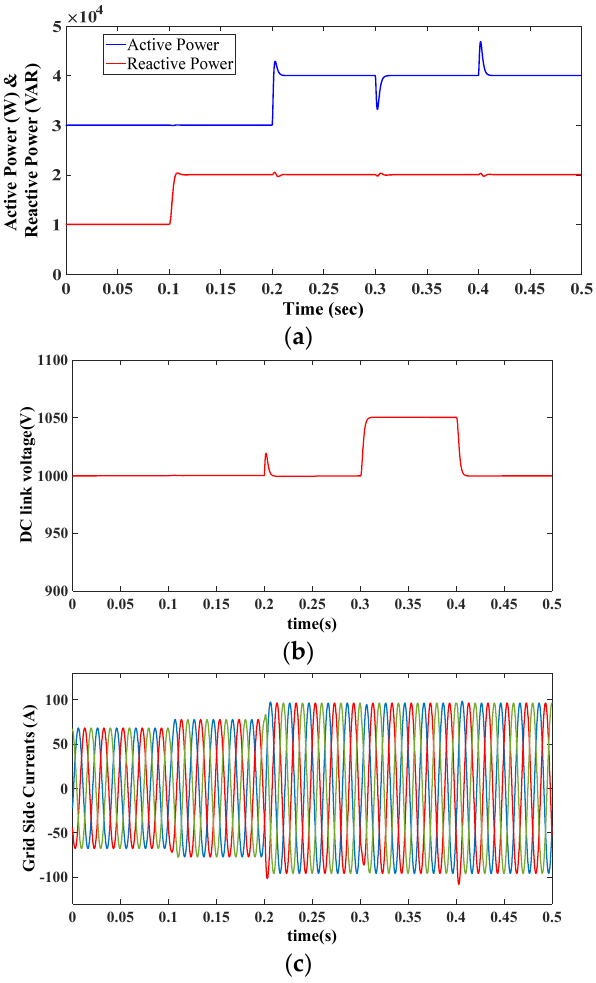
Figure 8. The response of the system connected to a zero-impedance grid; ( a ) the active and the reactive power, ( b ) the DC-link voltage, and ( c ) grid-side currents.